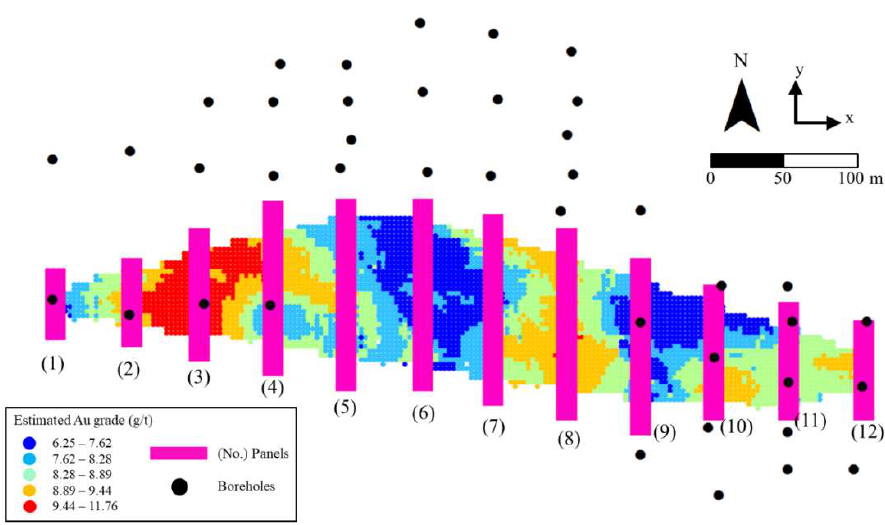
Figure 9. Constructed 12 panels which contain boreholes for validating local estimation.